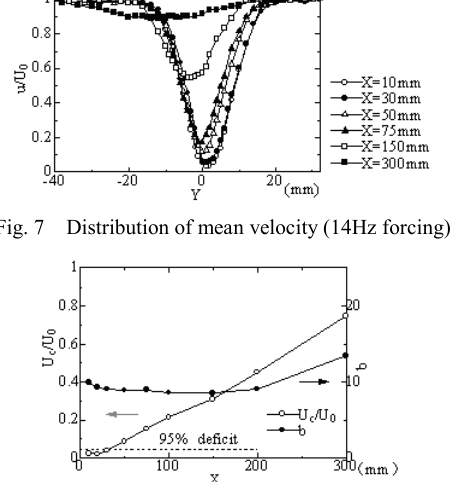
Fig. 6 Distribution of mean velocity (natural).